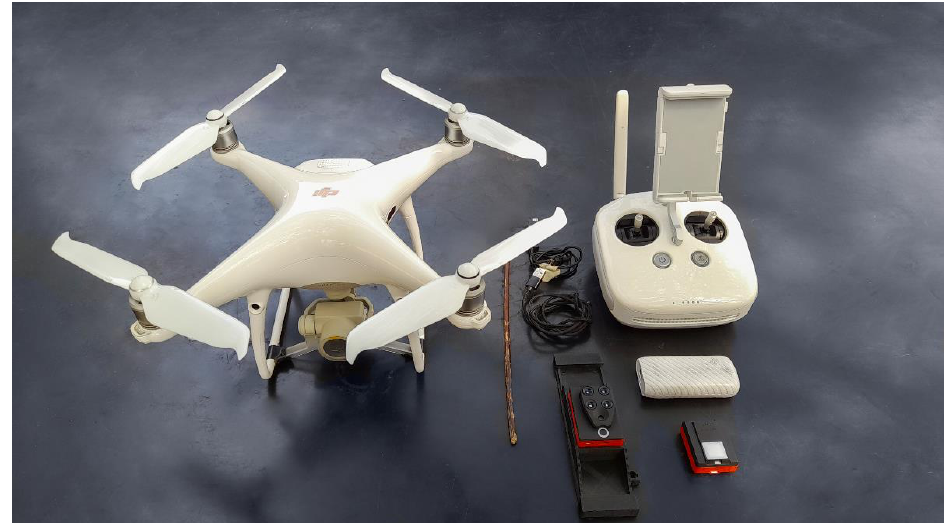
Figure 2. Equipment used in data collection. UAV and radio control, and Parrot Sequoia camera.